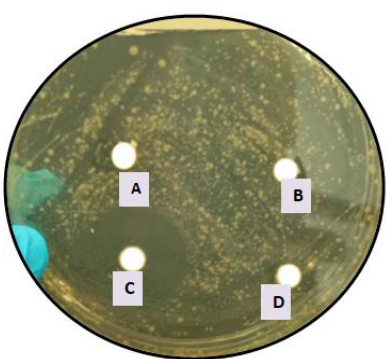
Figure 1: Pseudomonas aeruginosa; Antimicrobial activity of Diluted Scorpion venom by Agar-disc Figure 2: Pseudomonas aeruginosa;